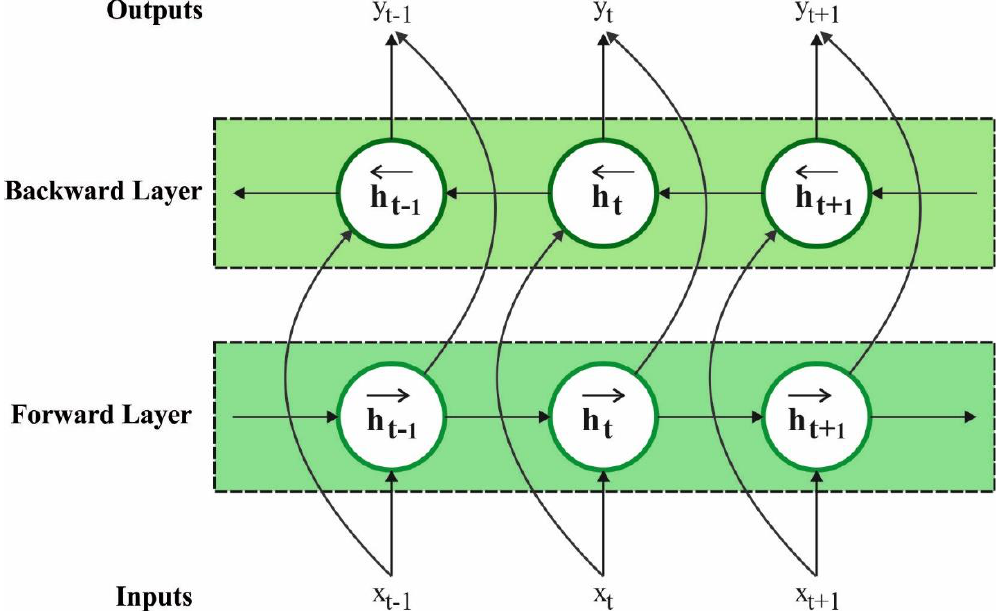
Figure 1. BLSTM structure.